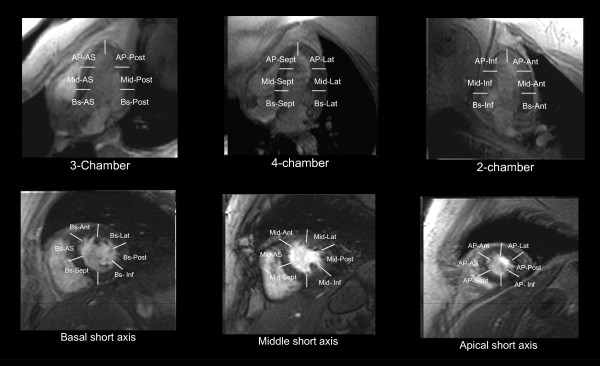
(Panel B): Myocardial segmentation during dobutamine stress CMR. Panel B: White lines demarcate the apical (AP), middle (Mid), and basal (Bs) segments of the anteroseptal (AS), anterior (Ant), lateral (Lat), posterior (Post), and inferior (Inf) walls.